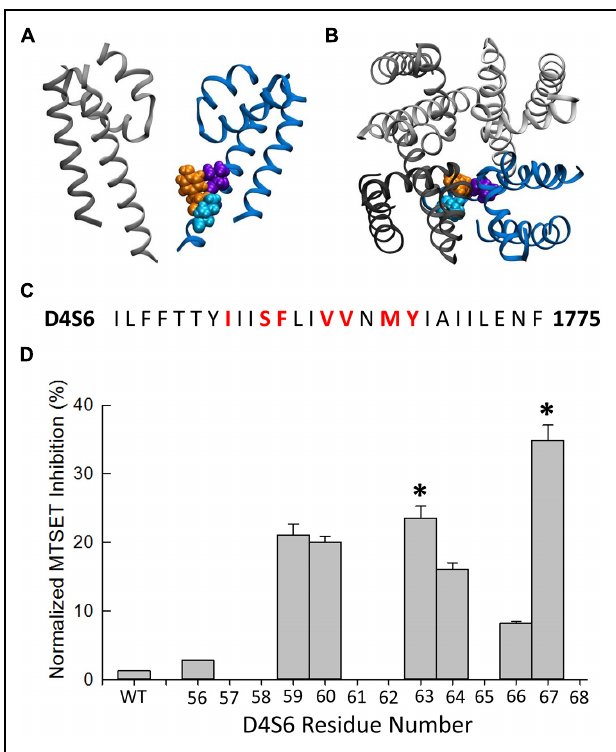
FIGURE 2 | Methanethiosulfonate reagent inhibition of D4S6 cysteine mutants. (A,B) Homology model of the Na v 1.5 pore-forming region (See Materials and Methods). Model shows the orientation of the Na v 1.5 D4S6 segment (blue) residues V1763 (purple), Y1767 (orange), and I1770 (cyan) viewed from the side (A) and top (B) of the channel. The D2 segment is shown in gray and the D1 (front) and D3 (back) segments were removed for clarity. (C) Primary amino acid sequence of the Na v 1.5 D4S6 segment. Residues mutated to cysteine are shown in red. (D) The Na + currents